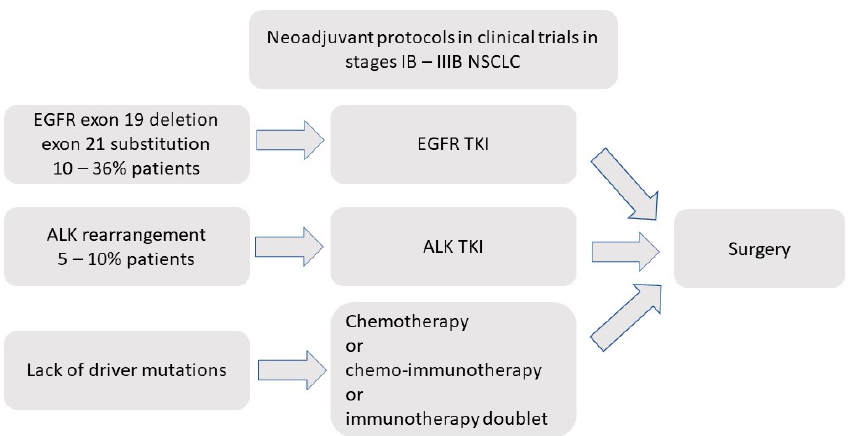
Figure 1. General study protocols of neoadjuvant approach in clinical trials. ALK-TKI anaplastic lymphoma kinase tyrosine kinase inhibitors, EGFR-TKI epidermal growth factor receptor tyrosine kinase inhibitors, NSCLC non-small cell lung